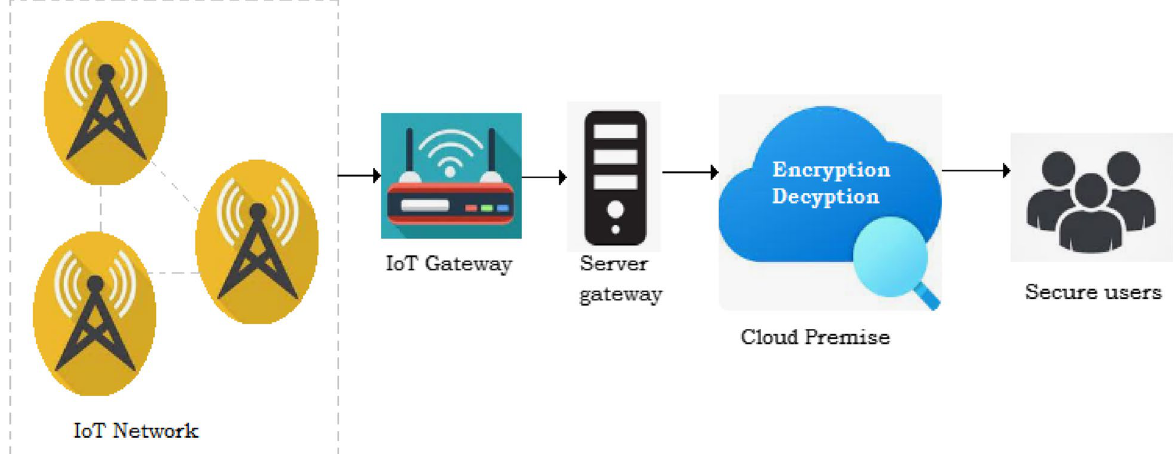
Fig. 1 General architecture of Secure cloud